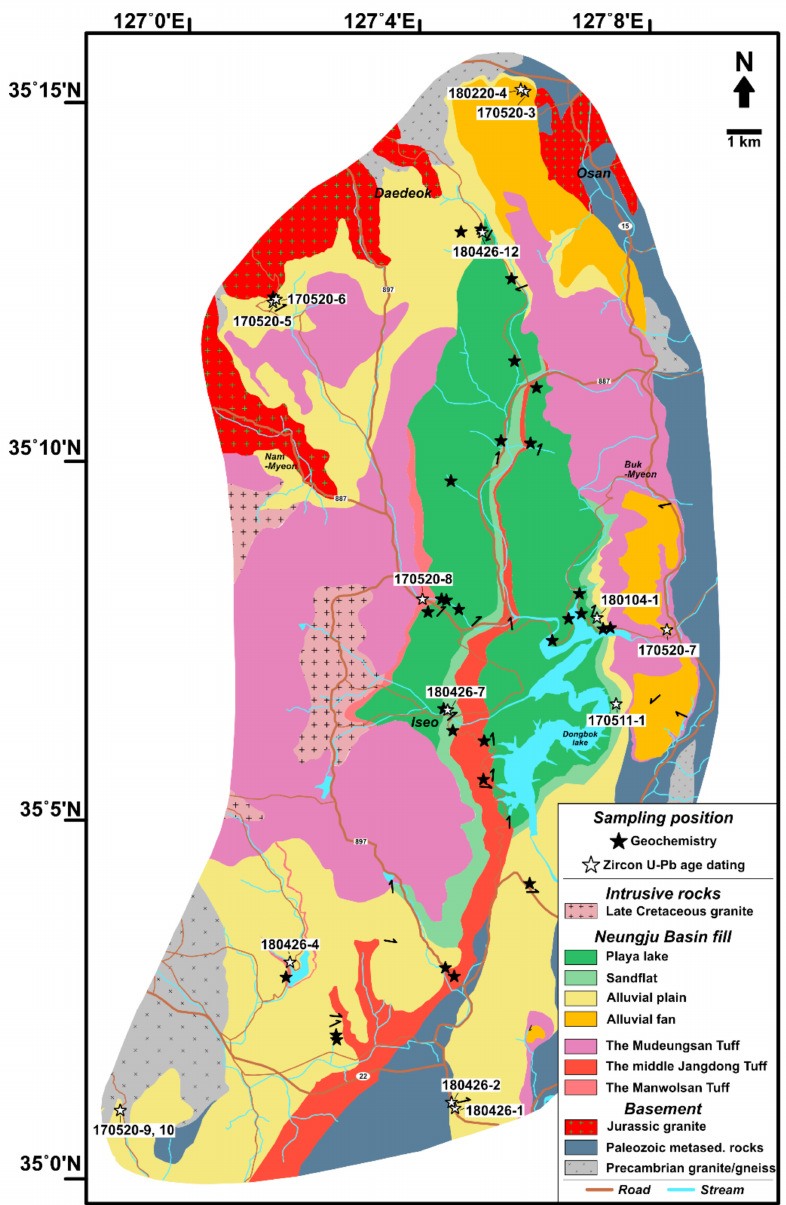
Figure 2. Spatial distribution of depositional environments in present outcrops of the Neungju Basin (modified after [26]). Sixteen mudstone samples were collected from the proximal depositional environments (alluvial plain and sandflat), and fourteen mudstone samples from the distal environment (playa lake). Samples were also collected from conglomerate, sandstone, and tu ff and analyzed in terms of zircon U-Pb geochronology to constrain sediment provenance and the depositional age of the basin. Sampling positions for geochemical analysis and zircon U-Pb dating are indicated by closed and open stars, respectively. Black arrows indicate paleocurrent direction